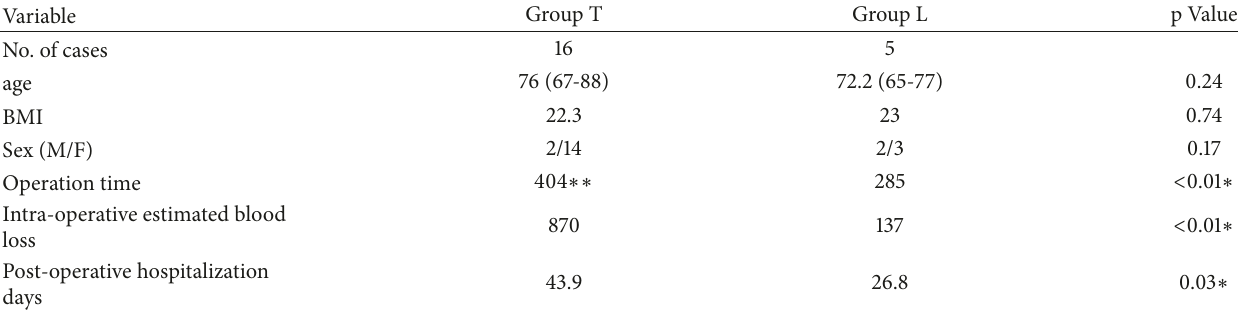
Table 2: Clinical and operative variables. BMI = Body Mass